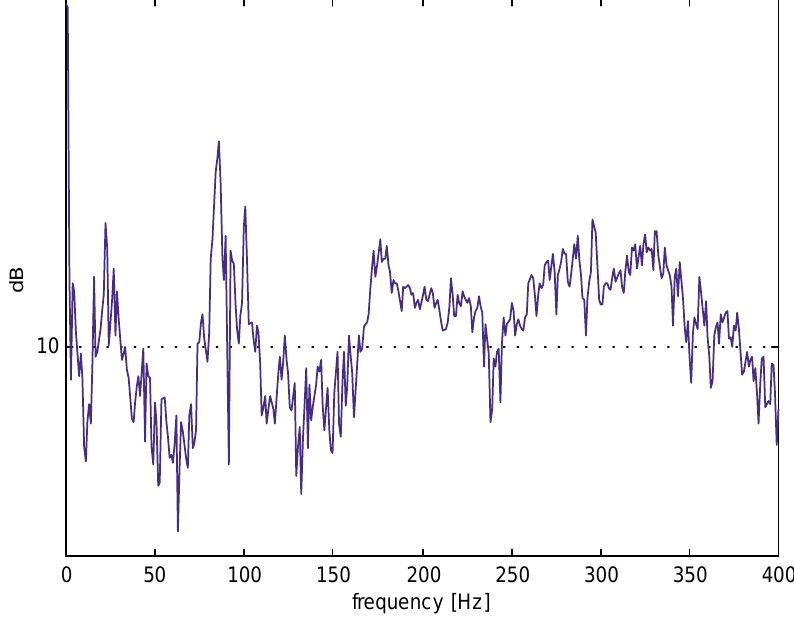
Fig. 8. Ratio between in-plane component to the 2 ◦ angle error